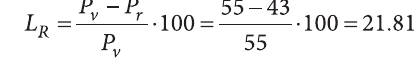
Table 9. Scores of safety indicators for compared schemes